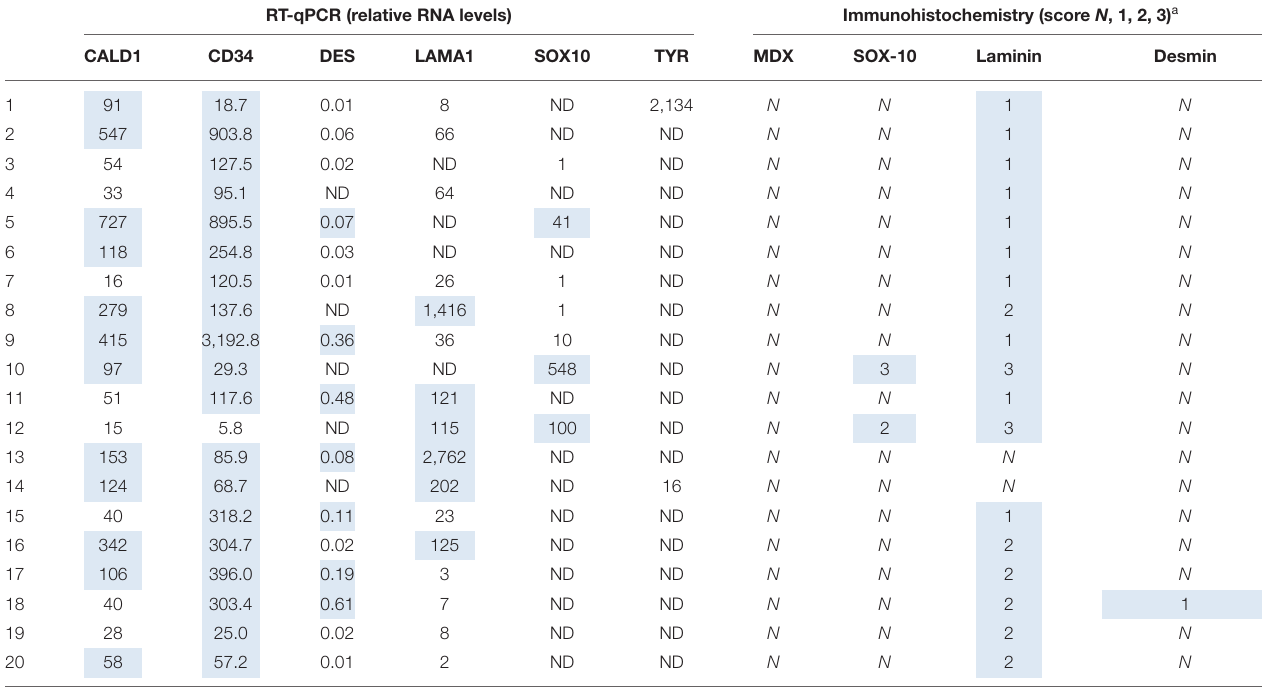
TABLE 5 | Relative RNA levels and immunoreactivity of soft tissue sarcoma. RT-qPCR (relative RNA levels)